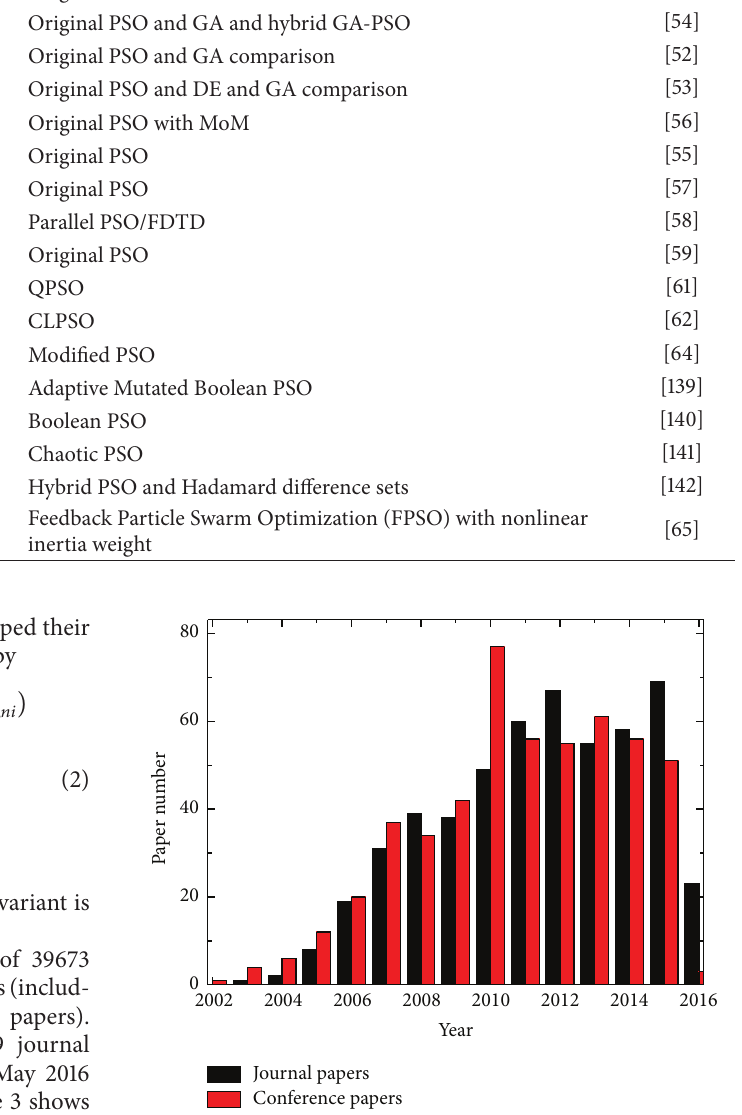
Figure 3: Papers using PSO for antenna design from 2002 to May